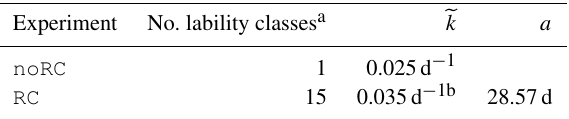
Figure 3. The particle data currently available. The blue squares present the stations of the data collection by Lam et al. (2011). The red crosses show the station coordinates of Hayes et al. (2015) and Lam et al. (2015b). The two black plus signs north of Hawaii and east of Bermuda are the stations of Druffel et al. (1992). The rectan- gles define the regions of the profiles discussed in Section 3 (green: up to 1km depth; blue: up to 6km